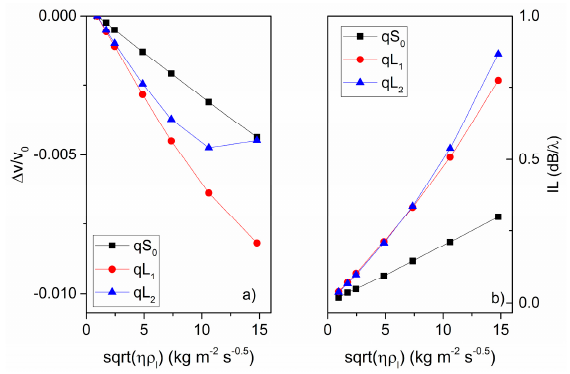
√ ηρ η and ρ l are the l , where